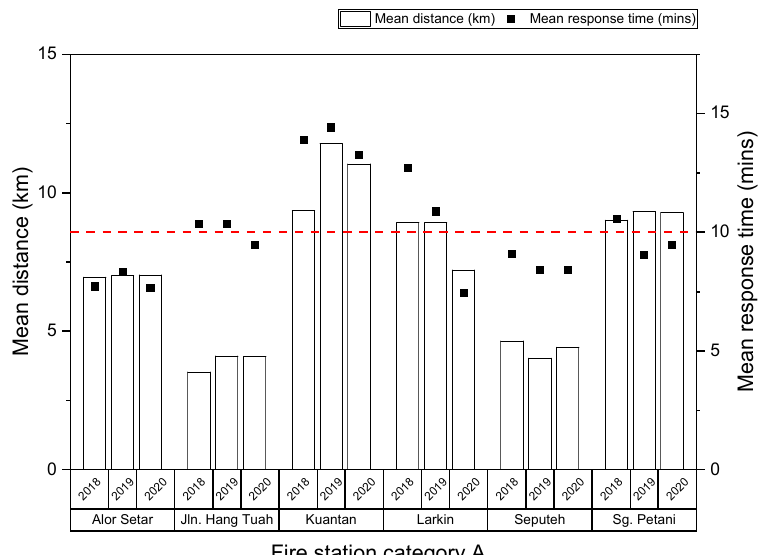
Figure 5. Mean distance and response time for category A fire stations. The red dash line is the mean response time benchmark for Malaysia.